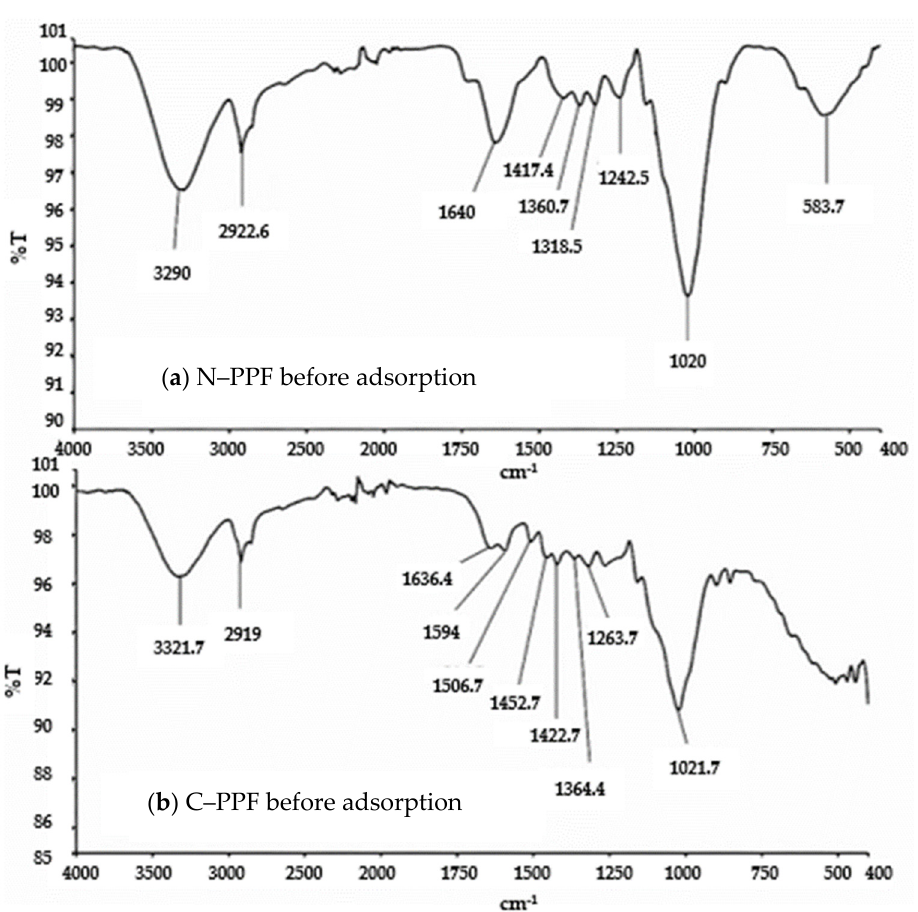
Figure 3. The functional group characteristic of FT–IR spectra between ( a ) N–PPF before adsorption and ( b ) C–PPF before adsorption.